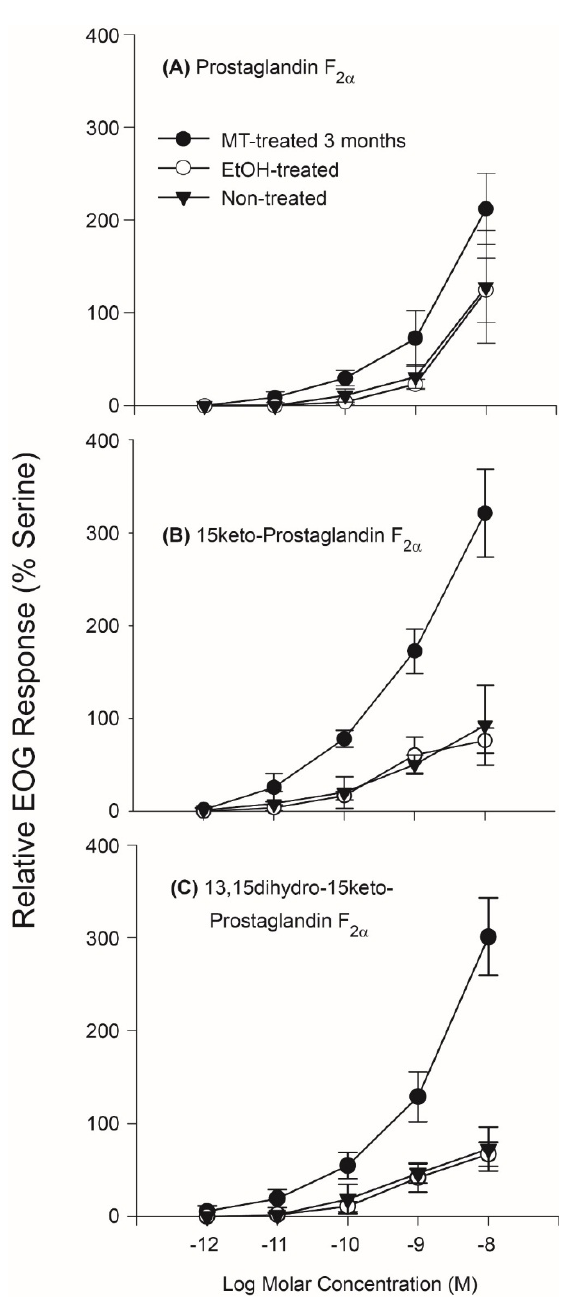
Figure 1. Mean olfactory responses (±95% confidence intervals) of untreated, control, and MT (masculinized) Silver Carp to: ( A ) PGF 2α , ( B ) 15K-PGF 2α , and ( C ) dh15K-PGF 2α , as measured by EOG recording (n = 3 for each group). Response sizes are expressed relative to the L-Serine standard.